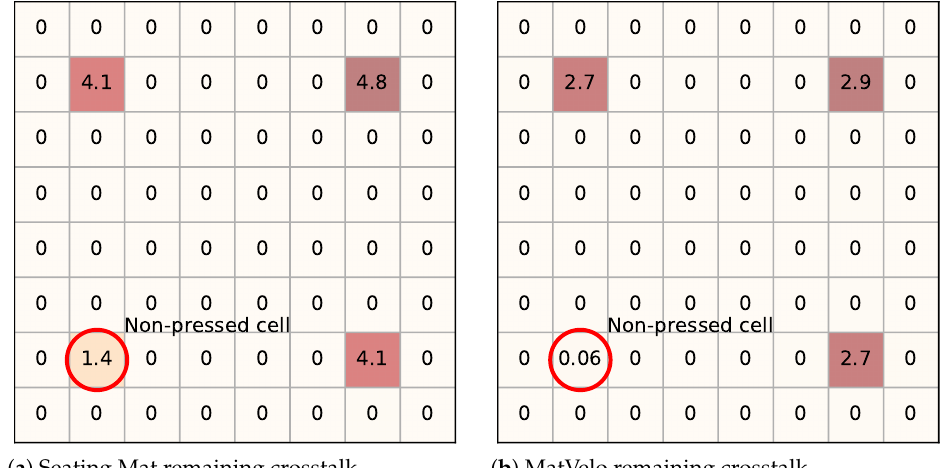
Figure 3. Excerpt of pressure images (arbitrary units) after elimination of crosstalk. ( a ) Seating Mat and ( b ) MatVelo remaining crosstalk.